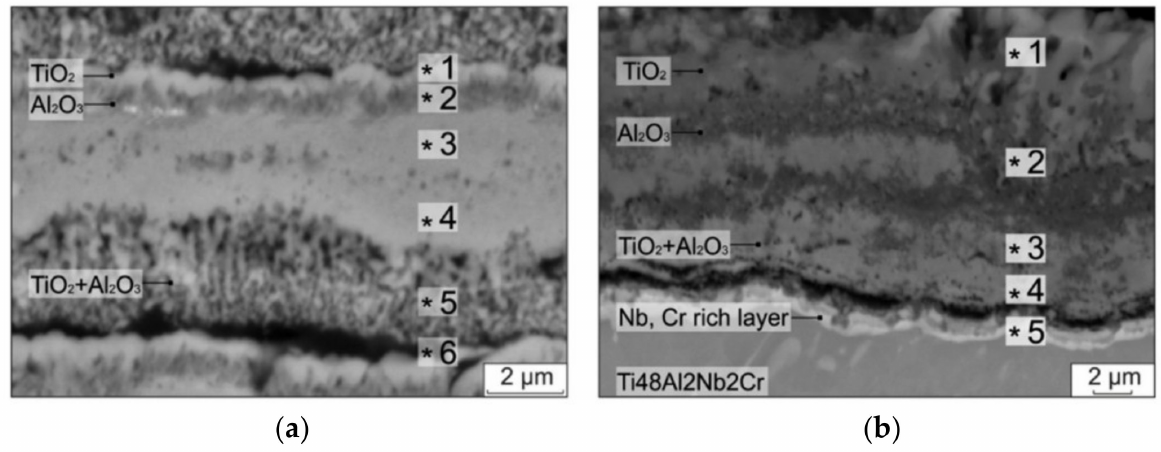
Figure 6. Cross-sectional SEM micrographs of oxide layers formed on ( a ) the Ti alloy substrate and ( b ) Ti-48Al-2Cr-2Nb exposed at 900 ◦ C for 100 h. Reprinted from Surface and Coatings Technology, 319, Iu.N. Maliutina, H. Si-Mohand, J. Sijobert, Ph. Bertrand, D.V. Lazurenko, I.A. Bataev, Structure and oxidation behaviour of γ -TiAl coating produced by laser cladding on titanium alloy, 136-144, Copyright (2017), with permission from Elsevier